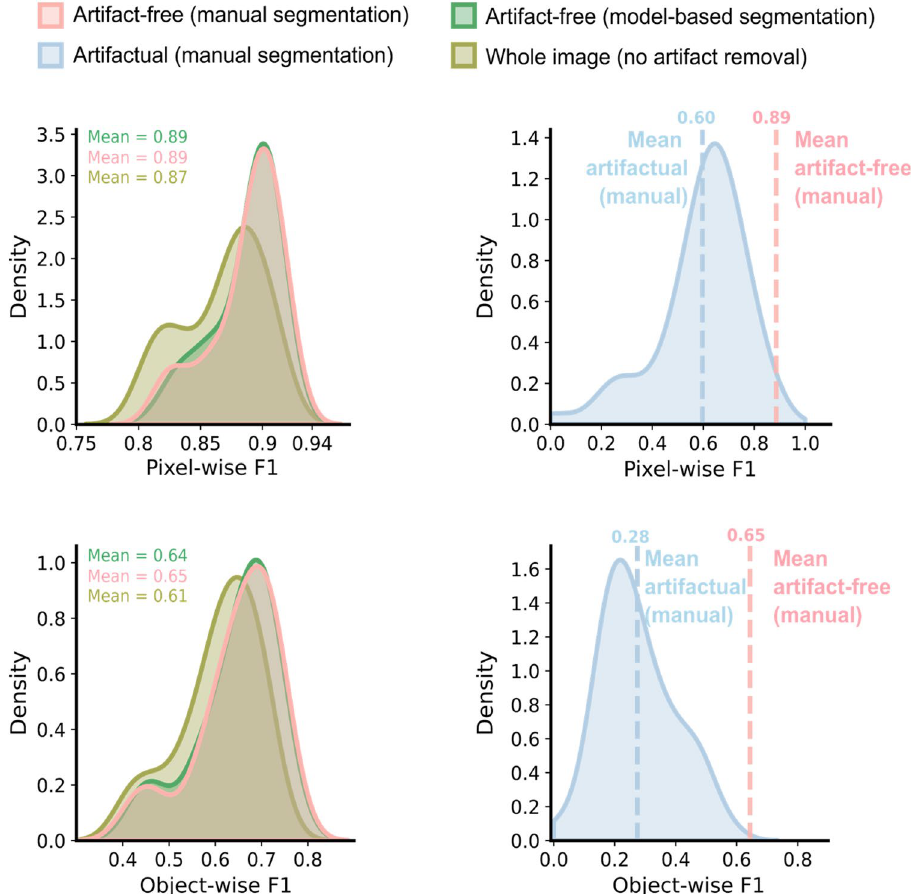
Figure 5. Impact of artifacts and artifact removal on downstream analyses. Density (y-axis) of image-average nucleus segmentation pixel-wise F1 (top, x-axis) and object-wise F1 (bottom, x-axis) in the seven cell lines dataset for different areas of the image (colors). Pink: area in the images manually annotated as not artifacts; blue: area in the images manually annotated as artifacts; green: area in the images automatically annotated as not artifacts by ScoreCAM-U-Net; yellow: all image area. Dashed lines: mean pixel-wise F1 and object-wise F1 of segmented nuclei in the artifactual and artifact-free regions (different